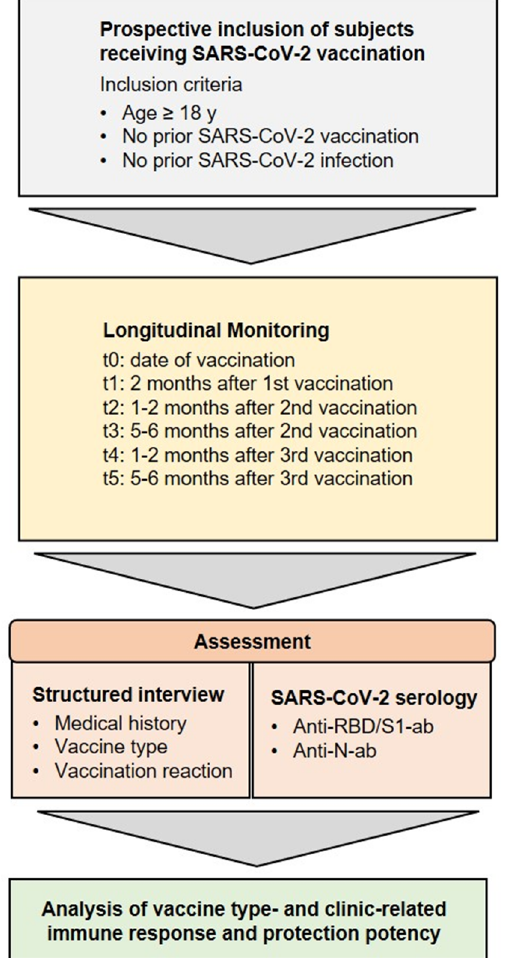
Figure 1. Study aims.